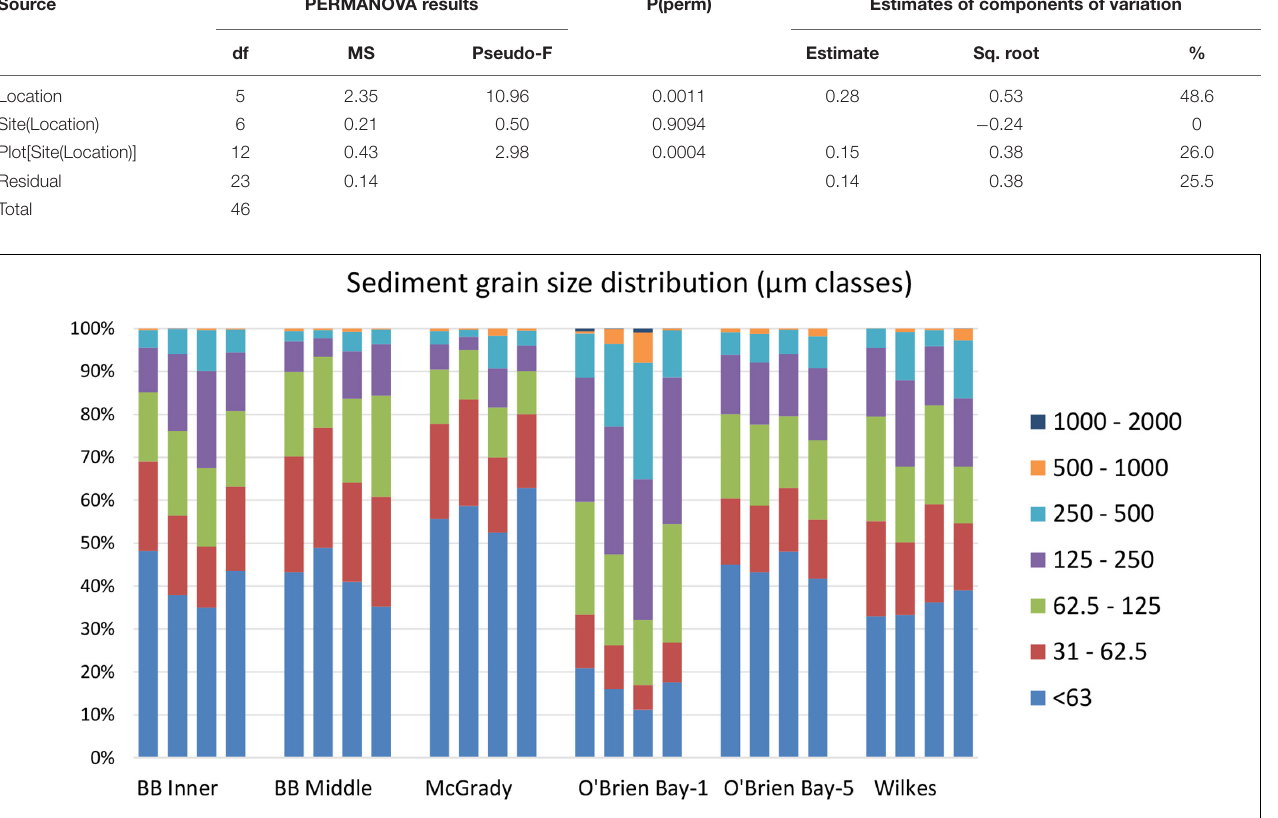
FIGURE 6 | Average sediment grain size category% in each of four plots ( n = 2) at each